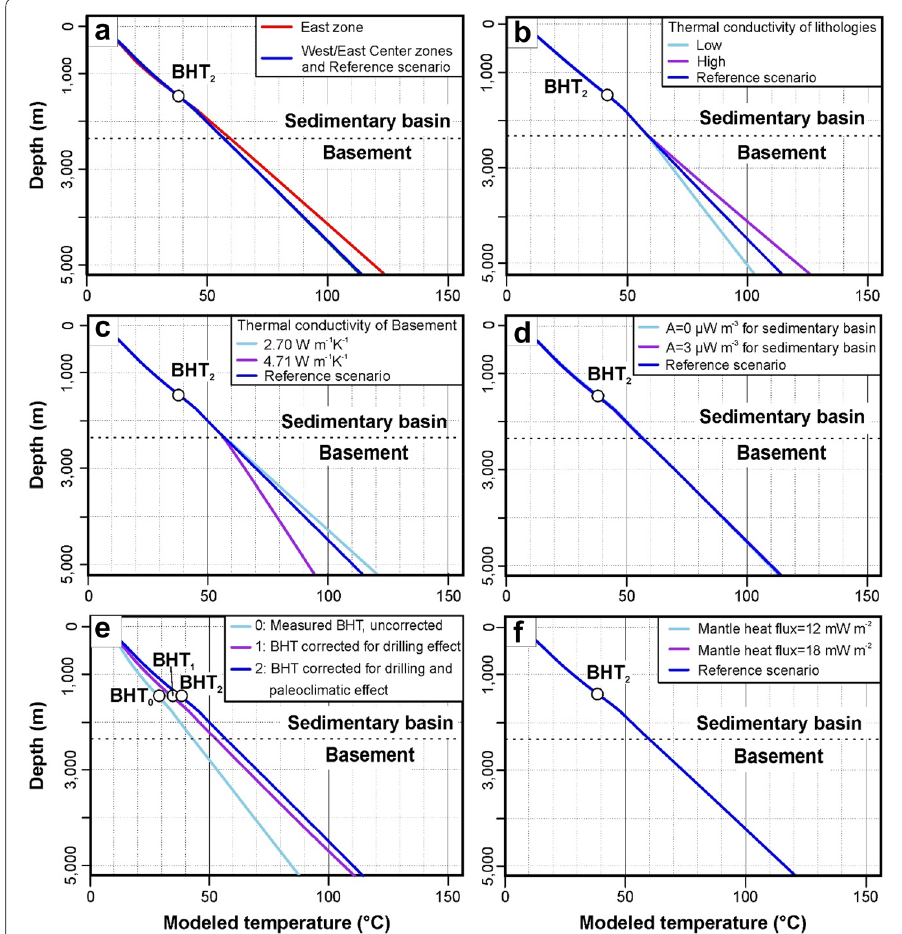
Fig. 11 Temperature sensitivity with respect to thermal parameters considered computing analytical 1D profiles, using DZ017 well. Impact of a lithology from the synthetic logs of other zones are applied to the calculation of the thermal conductivity and heat generation rate in the sedimentary thermal units; b the thermal conductivity assigned to the lithologies of sedimentary thermal units; c the thermal conductivity assigned to the Basement thermal unit; d heat generation rate assigned to the entire sedimentary basin; e BHT corrections, and f mantle heat flux were evaluated